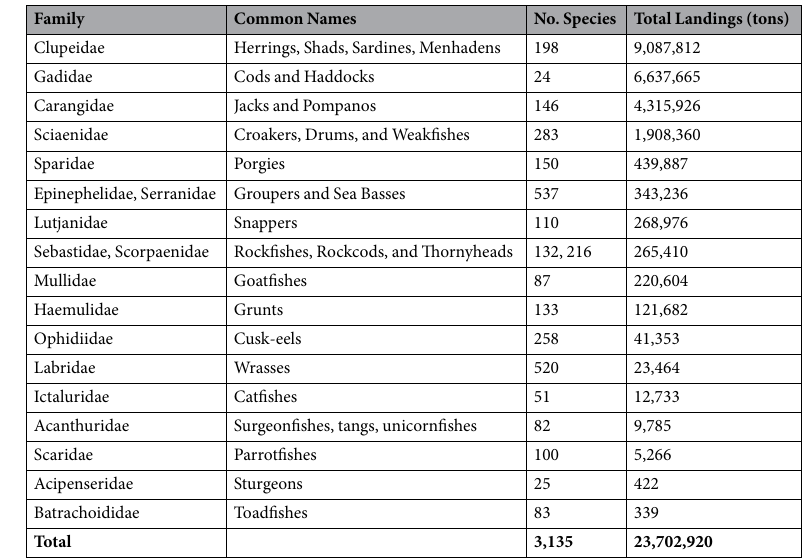
Table 1. Families of commercially important fishes that have been documented to produce sounds and form spawning aggregations. The table presents total global landings (tons) reported in 2013 (FAO) for aggregating, sound producing families of fishes. Families are organized by total landings. Sciaenidae, ranking fourth in contributions to landings, supports global economies and is need of new assessment methods to ensure sustained